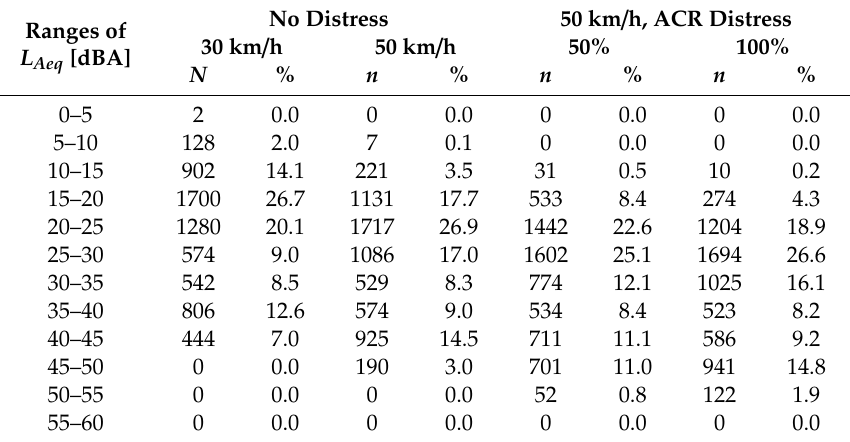
Table 9. Population exposed to noise, GGA pavement— L Aeq